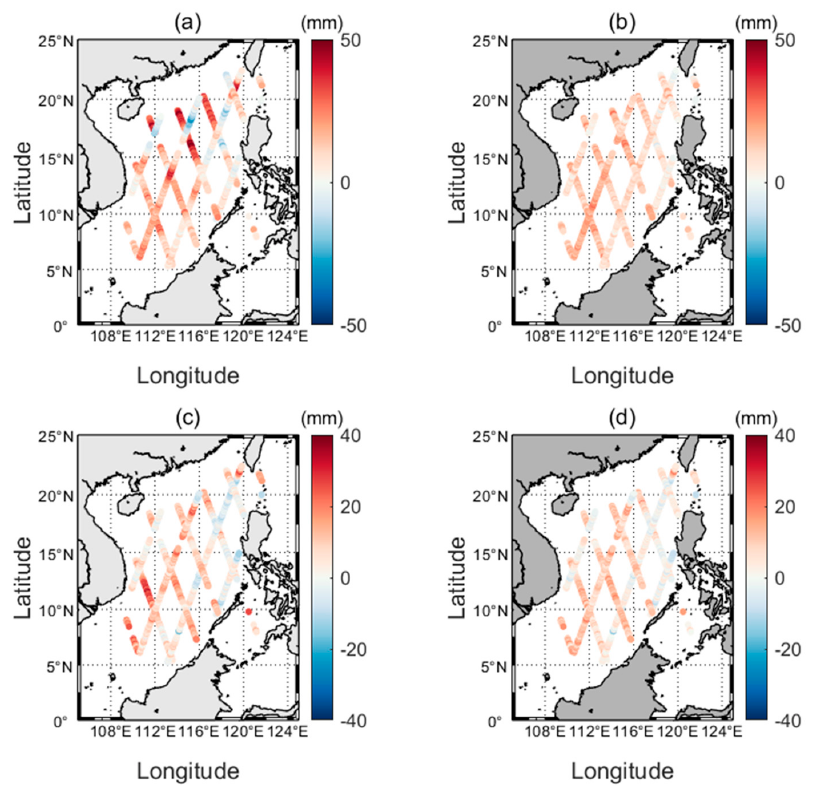
Figure 10. Comparison of evolution of K 1 and O 1 tidal amplitudes before and after the MVC: ( a ) evolution of K 1 tidal amplitudes before correction; ( b ) evolution of K 1 tidal amplitudes after correction; ( c ) evolution of O 1 tidal amplitudes before correction; ( d ) evolution of O 1 tidal amplitudes after correction.